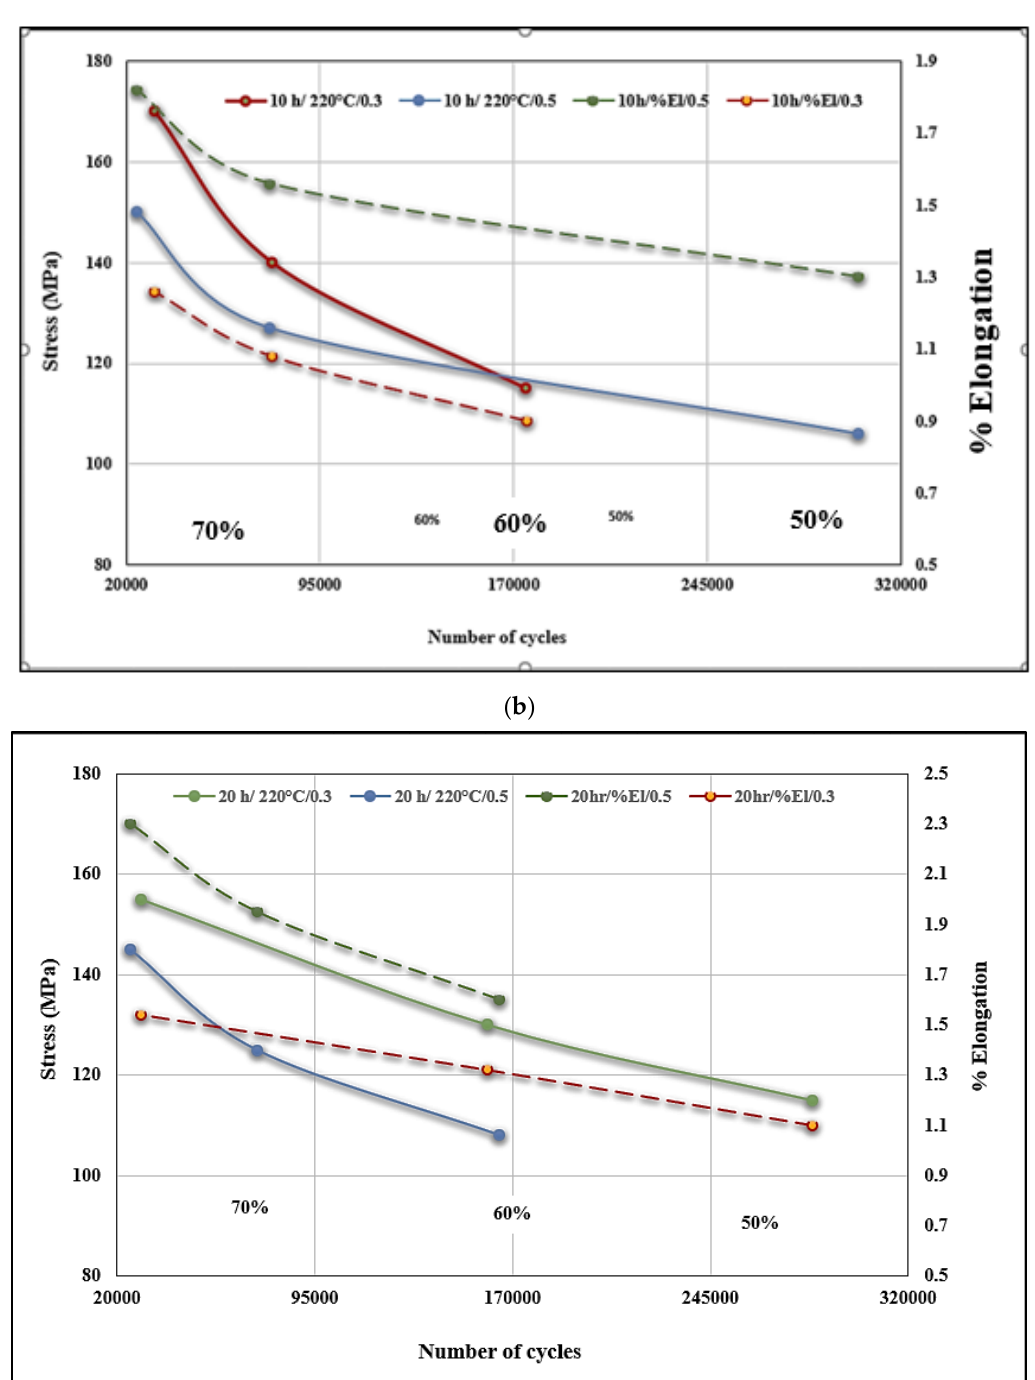
Figure 17. S – N plots for ( a ) alloy A aged at 155 °C and 220 °C for different times; ( b ) alloys B and C aged for 10 h/220 °C; and ( c ) alloys B and C aged for 20 h/220 °C. Yang et al. [44] studied the effect of rotating – bending fatigue on the lifetime of a 7075 alloy in the T6 condition. Their observations show that the fatigue crack initiation takes place at the sample outer surface (marked 1) and propagation (a smooth rubbed surface- marked 2), followed by a rough area in relief indicating final break (marked 3), as illus- trated schematically in Figure 18a. However, this type of fracture normally occurs under mechanical fatigue testing caused by alternate compression – tension, an example of which is shown in Figure 18b.